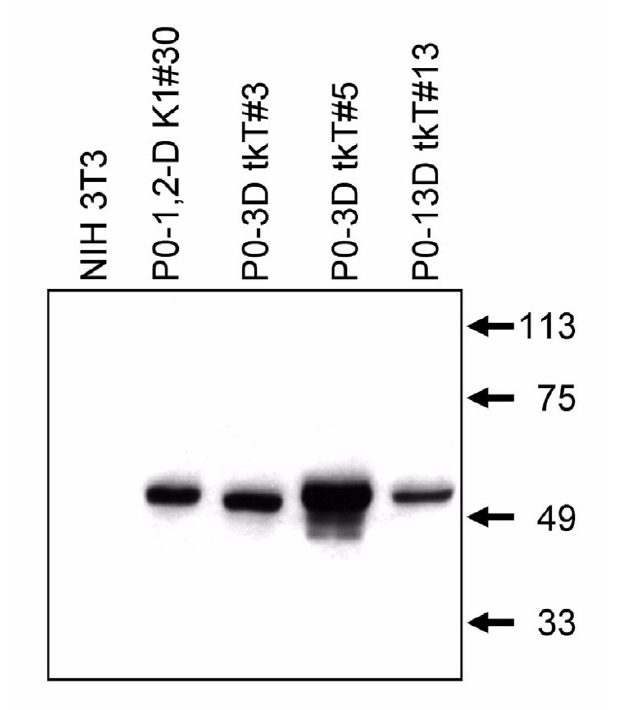
Figure 1 GFAP expression in the Linker tkT cell lines . The tkT cell lines and NIH 3T3 cells were grown in 1 mM dibutyryl cAMP for 3 to 8 days. Intermediate filament extracts from 1 to 6 × 10 5 cells were loaded in each lane and subjected to SDS PAGE and Western blotting. The membranes were immunostained for GFAP, which is specific for astrocytes. All of the astrocyte cell lines expressed GFAP and the NIH 3T3 cells did